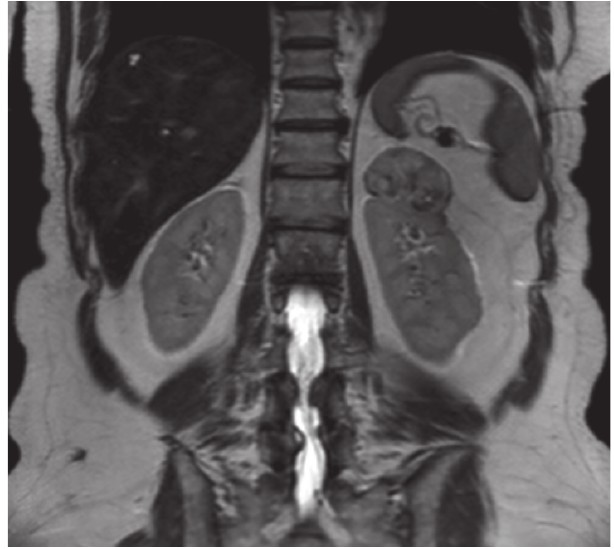
Figure 1. Mass in the left upper renal pole (T2-weighted MR image) with a size of 48×48×33 mm having a diffusely